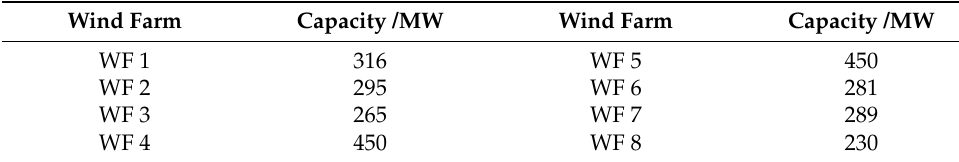
Table 1. Wind farm installed capacity of